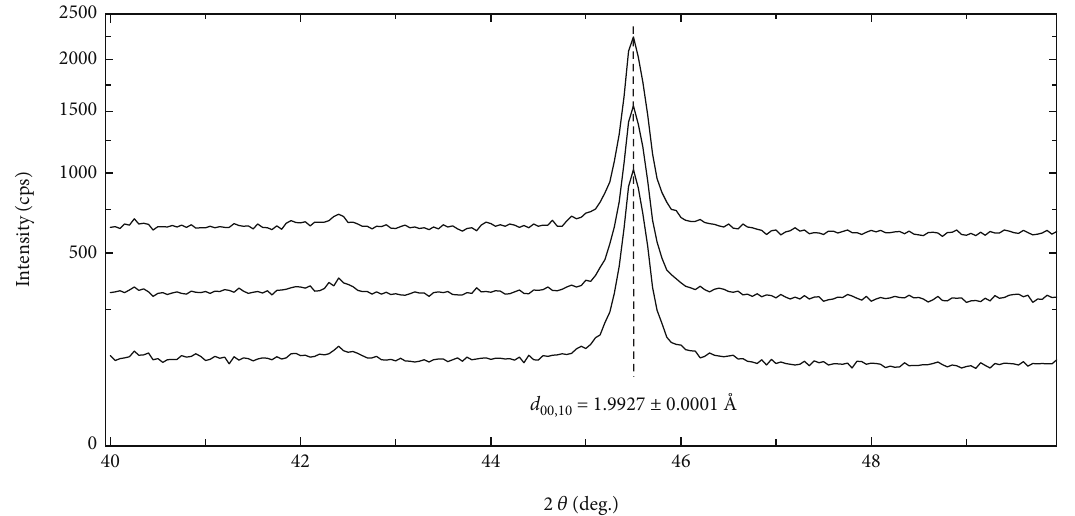
Figure 4: XRPD patterns of (00,10) basal re fl ection of the studied red bed sample measured in triplicate (sample Kel – 14; < 2 μ m fraction, air- dry, highly oriented specimen). The d spacing of 1 : 9927 ± 0 : 0001Å indicates near pure “ muscovite ” composition of the white